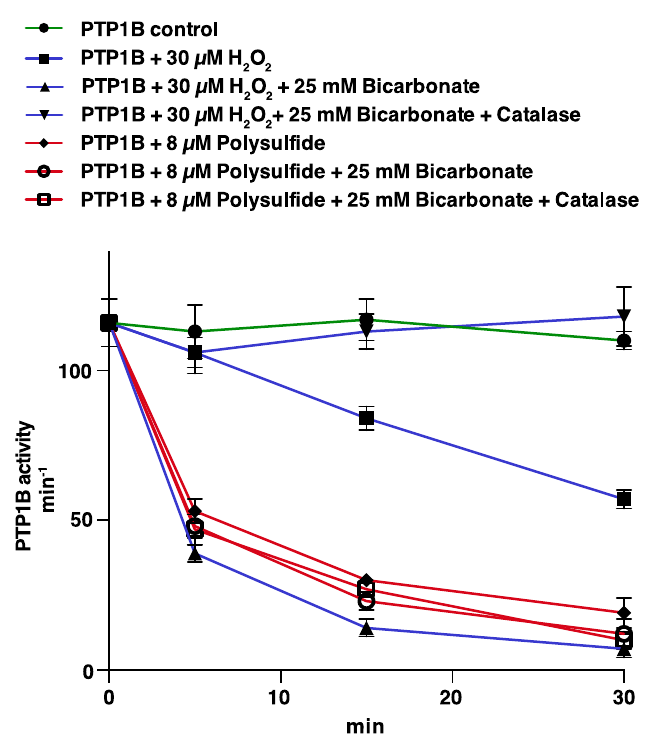
Figure 1. Bicarbonate/H 2 O 2 - and polysulfide-mediated inactivation of PTP1B compared. Recombinant PTP1B (600 nM) was treated with 30 µ M of H 2 O 2 (blue curves) or 8 µ M polysulfide (red curves) with and without addition of 25 mM HCO 3 − and catalase (20 µ g/mL), as indicated in the figure. All incubations were done in 20 mM HEPES, 100 mM NaCl buffer pH 7.4 containing 0.1 mM EDTA, 0.05% bovine serum albumin (BSA) and 1 mM sodium azide, with subsequent measurements of PTP activity at the indicated times. PTP1B activity is given in min − 1 (mol product formed/mol PTP1B/min). Data points represent means ± SEM ( n = 4).